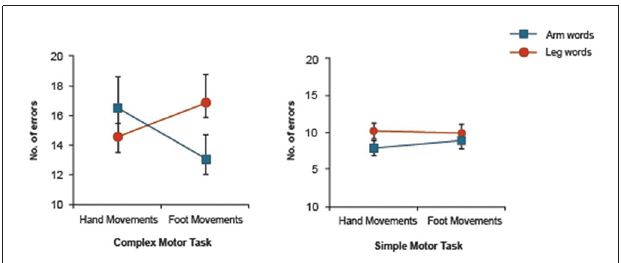
FIGURE 2 | Three-way interaction of Word Category × Motor Movement × Task Complexity interaction in the experiment reported in Shebani and Pulvermüller (2013; complex motor task) and the present study (simple motor task). When simple movements are carried out, the inhibitory effect of motor activity on body-part-congruent language memory is reversed for arm-related words.